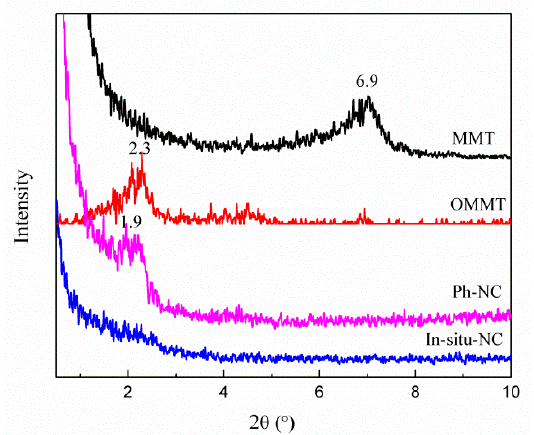
Figure 1. X-ray diffraction patterns of montmorillonite (MMT), organic MMT and 1,2-PB nanocomposite (ph-NC), and in-situ-NC.